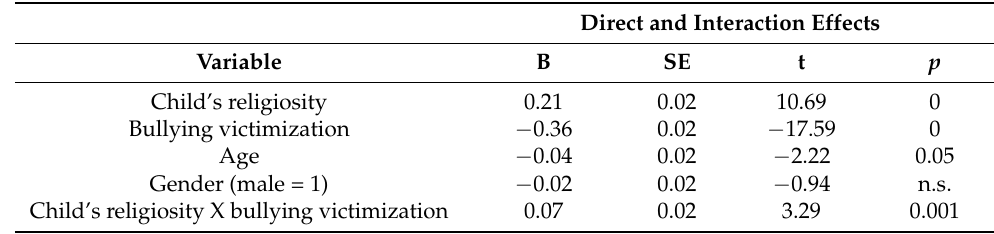
Table 2. Regression results of the moderation model predicting child’s subjective well-being (Domain Based Subjective Well-Being Scale—DBSWB) (N = 2733).